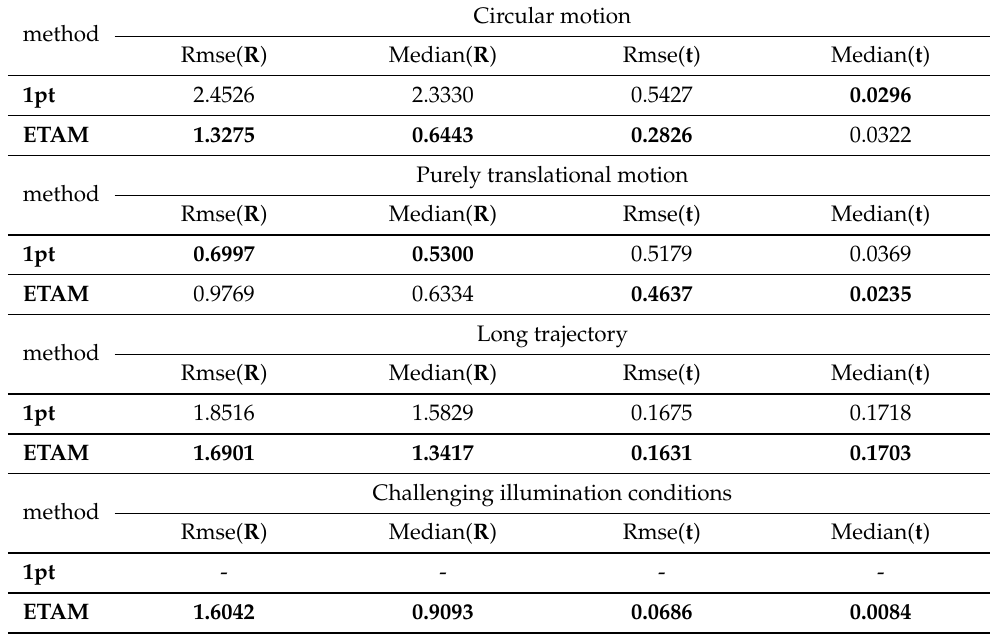
Table 1. Accuracy on different sequences. Unit: [deg/s].